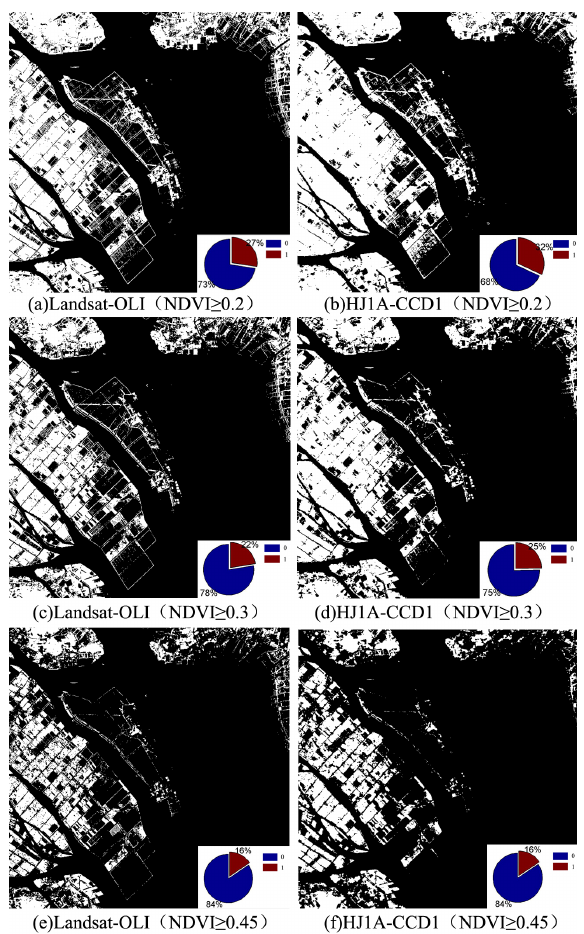
Figure 7. NDVI images of Landsat-OLI and HJ1A-CCD1 at different